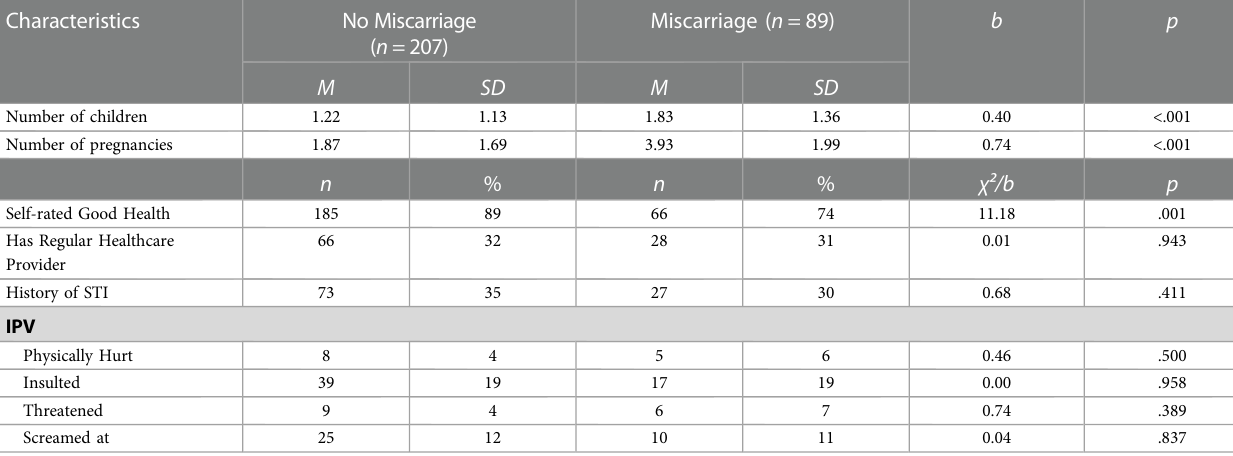
TABLE 3 Health-Related characteristics of latinas with a history of miscarriag e.